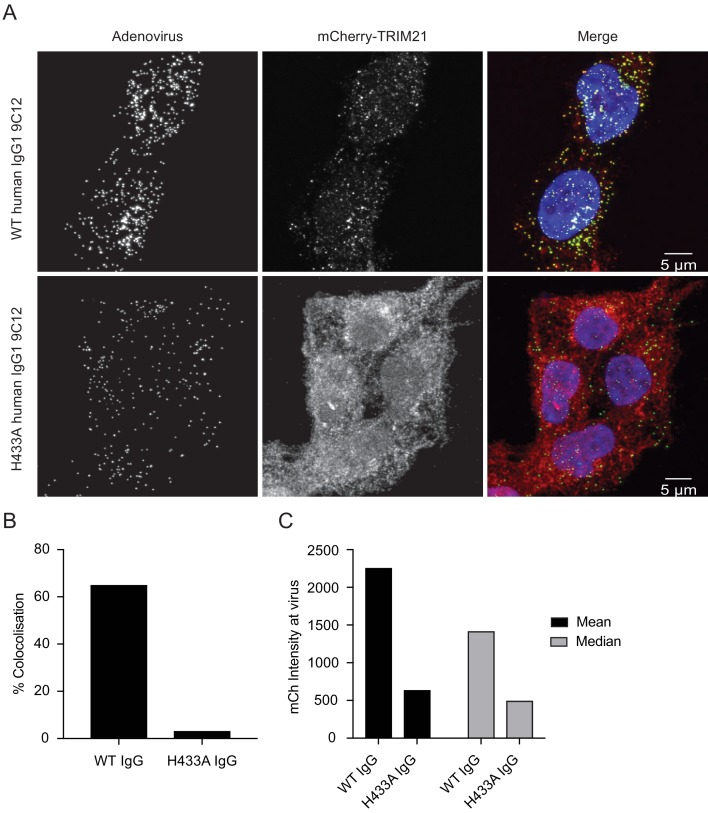
Native promoter driven mCherry-TRIM21 colocalizes with antibody coated AdV5.(A) Confocal microscopy images staining for human IgG and mCherry in TRIM21 KO 293Ts reconstituted with mCherry-TRIM21 driven by the native TRIM21 promoter. The cells were fixed 30 min after infection by AdV5 coated with either WT 9C12 or 9C12 with the H433A mutation in its Fc. (B) Quantification of colocalization between 9C12-AdV5 and mCherry-TRIM21 using the ComDet plugin in Fiji (Schindelin et al., 2012). (C) Quantification of the mean and median mCherry intensities at 9C12-AdV5 spots using the ComDet plugin in Fiji (Schindelin et al., 2012). Data provided in Figure 5—source data 1.